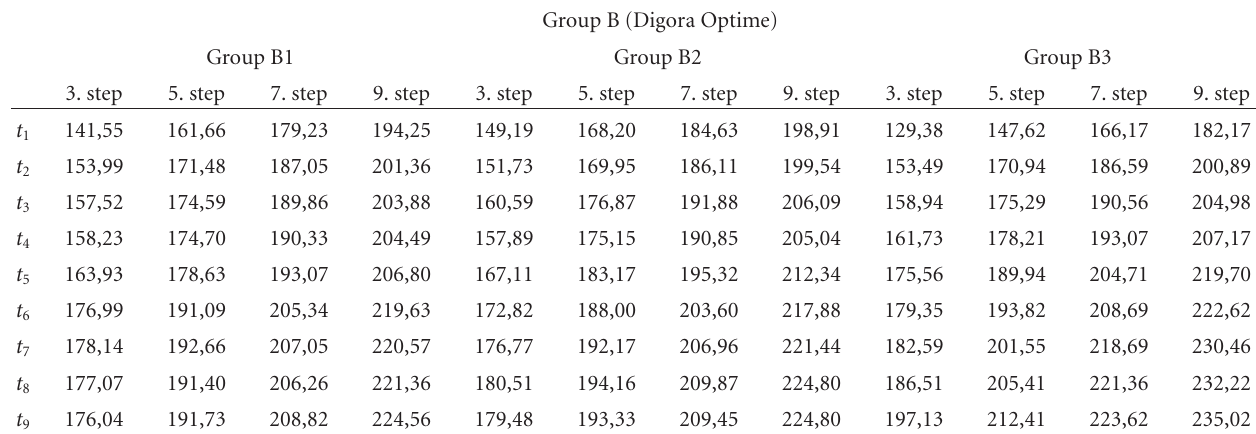
Table 2: The MGVs of the plates for Group B according to delay in scanning